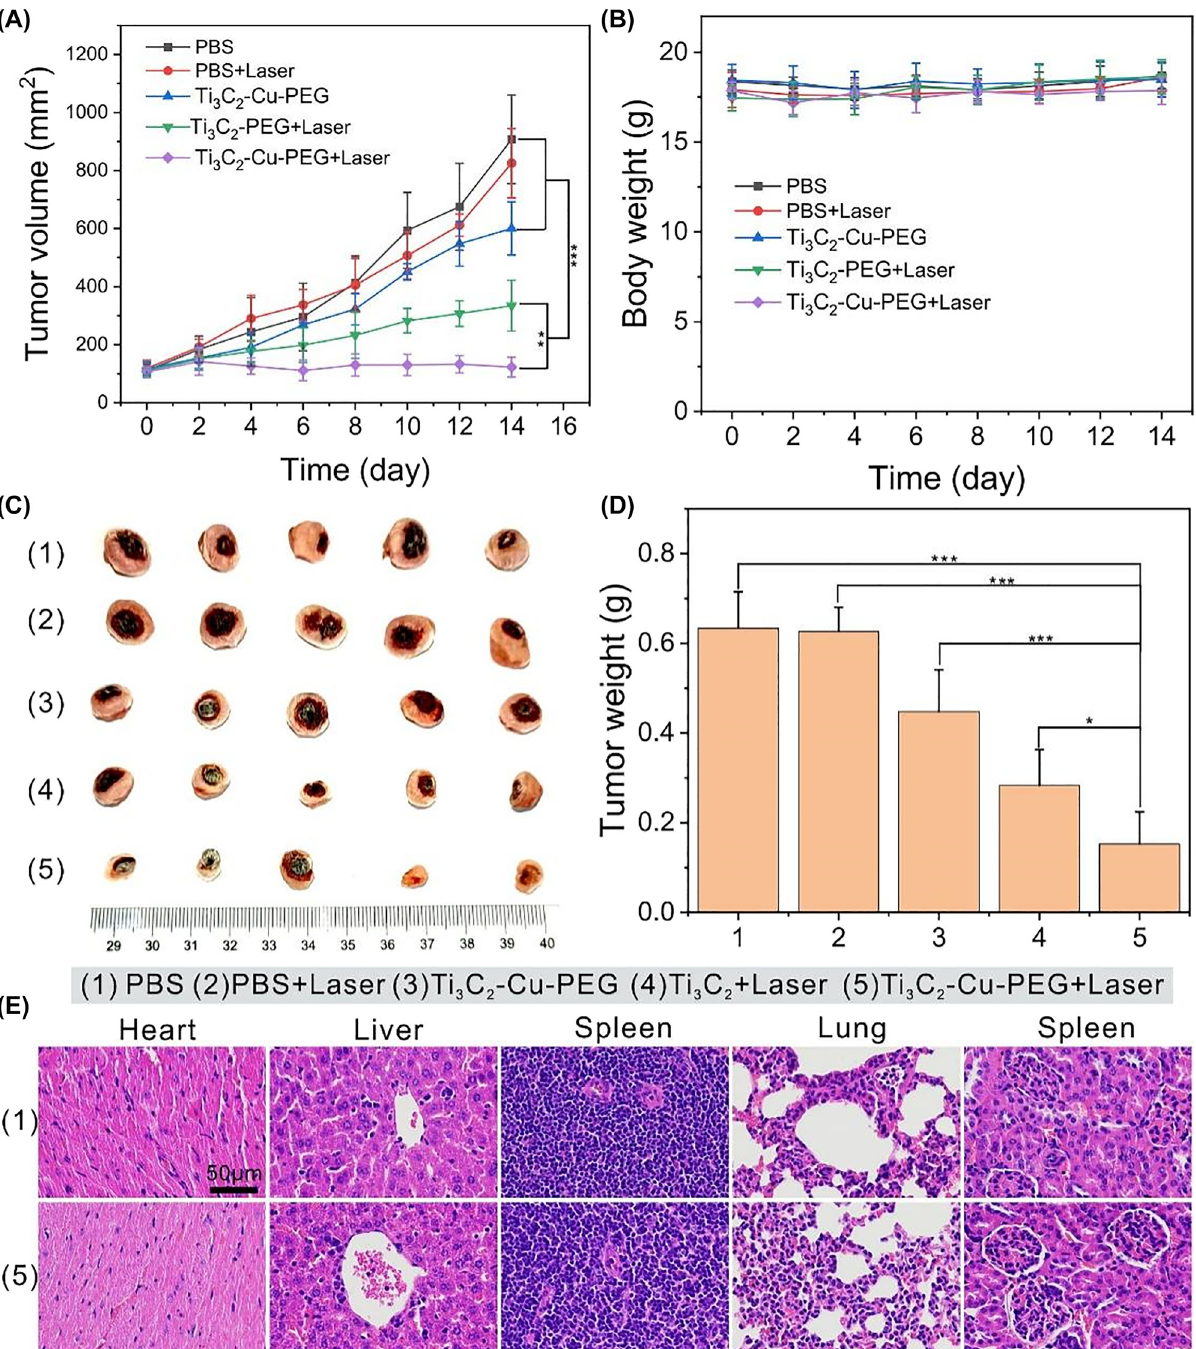
Figure 7: In vivo synergistic GSH-depletion and photothermal-enhanced nanodynamic therapy. (A) The tumor volume curves, and (B) body weight curves of mice in various groups ( n = 5). (C) Digital photos of isolated tumors from different groups after treatments on 14th. (D) Tumor weights after treatments. (E) H&E staining of major organs from PBS and TTi